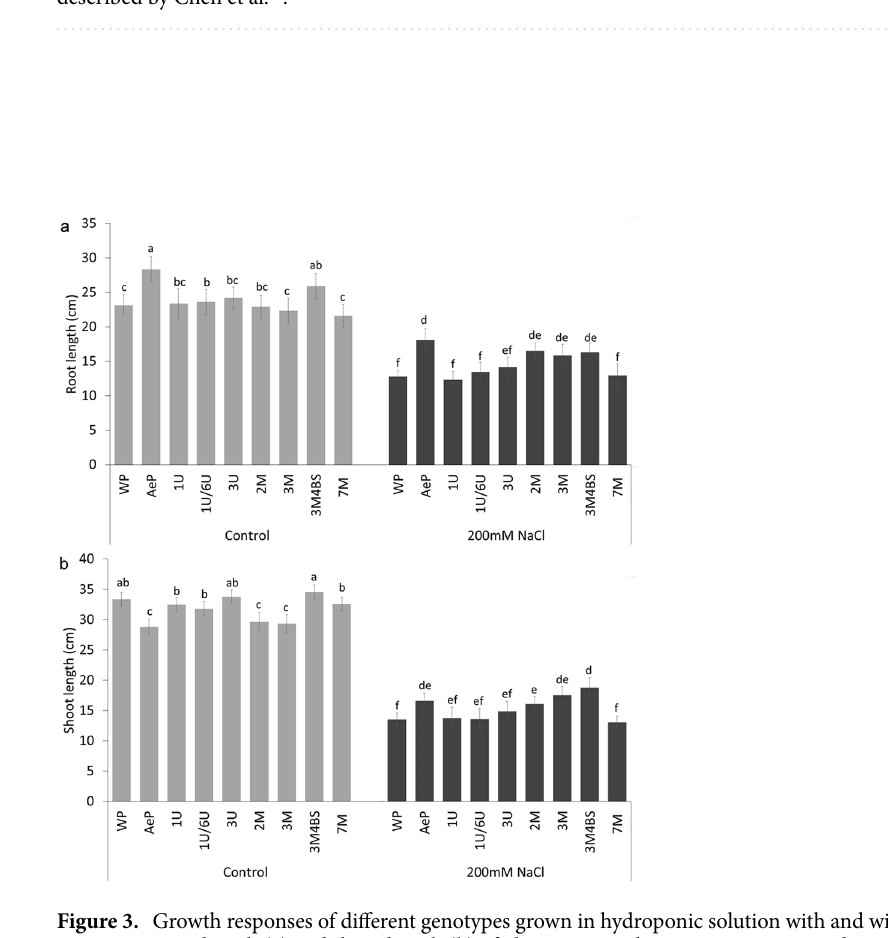
Figure 2. Membership functional values (MFV) of salt tolerance indices (STI) according to 5 traits of each genotype (WP–wheat parent; AeP— Aegilops parent and addition lines). The calculation was performed as described by Chen et al. 35 .